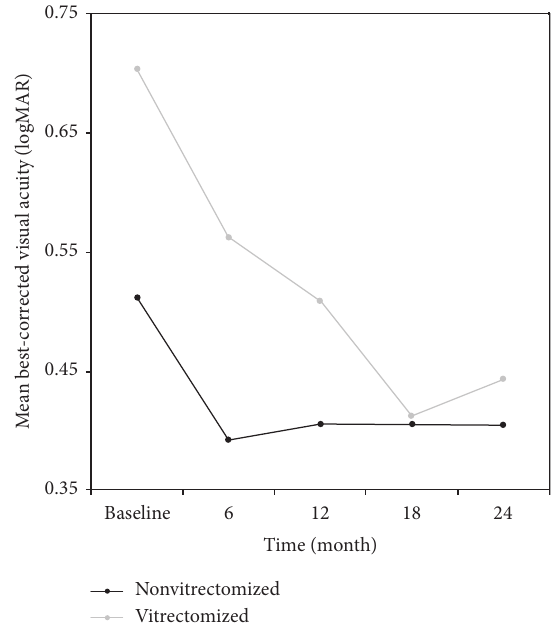
Figure 2: Changes in the mean visual acuity (in logMAR) of the study groups during 24 months of follow-up. BCVA indicates best- corrected visual acuity. Post hoc tests using the Bonferroni cor- rection revealed that IVR treatment elicited a significant im- provement in BCVA values from baseline to 6th month of treatment (0.51 ± 0.26 vs. 0.39 ± 0.26, p � 0 . 036) in the non- vitrectomized group.